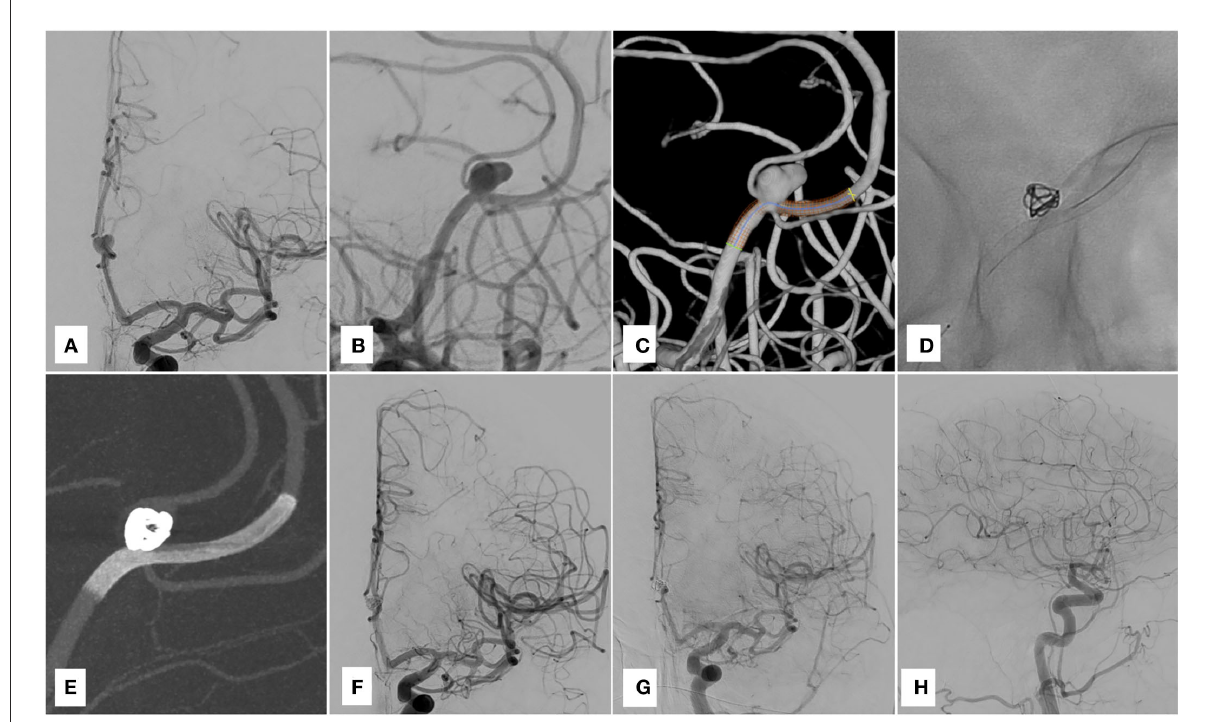
FIGURE2 Case 2. (A–C) Pre-treatment DSA and 3D reconstruction. (D) Derivo 2 deployed. (E,F) Post-treatment run and Vaso-CT. (G,H) Six-month-DSA follow-up.